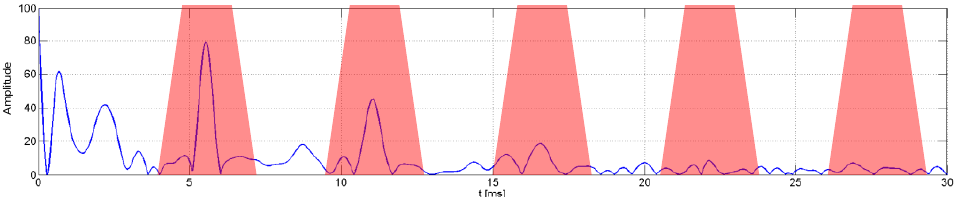
Figure 4. A method of setting weighted cepstral features from real cepstrum based on trapezoidal weighted function [17].